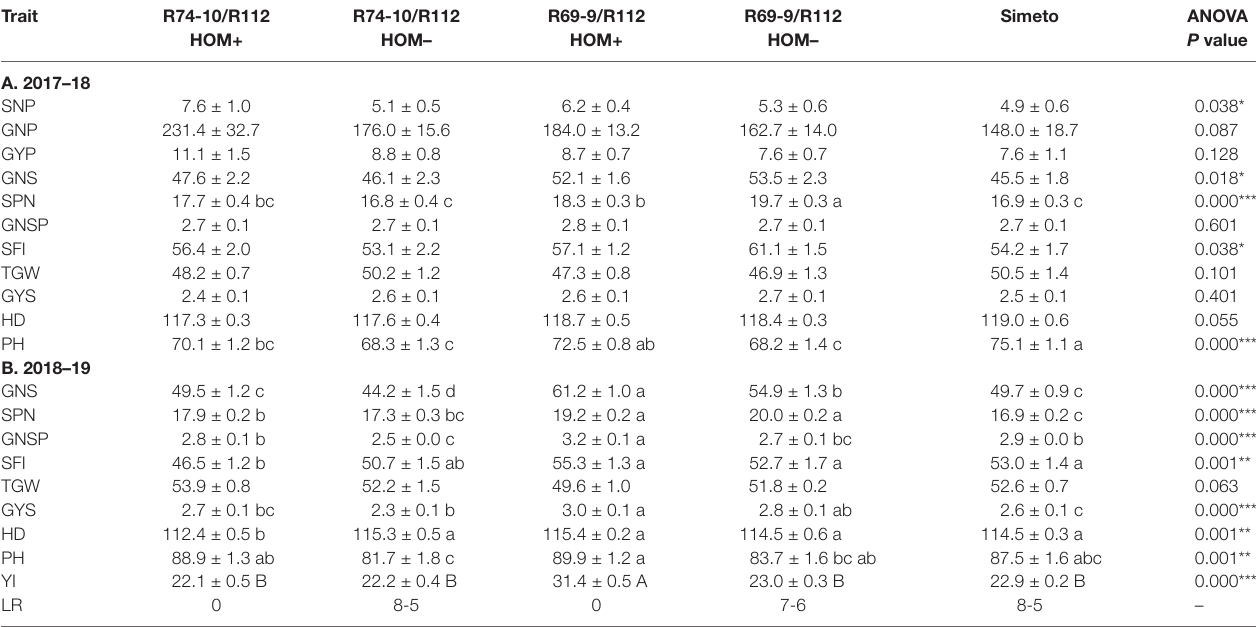
TABLE 7 | Spike and plant traits of field-grown homozygous (HOM+) recombinants (R74-10 or R69-9/R112/2*Simeto F 3-4 derivatives) compared to corresponding HOM– segregates and to the recurrent cv. Simeto.